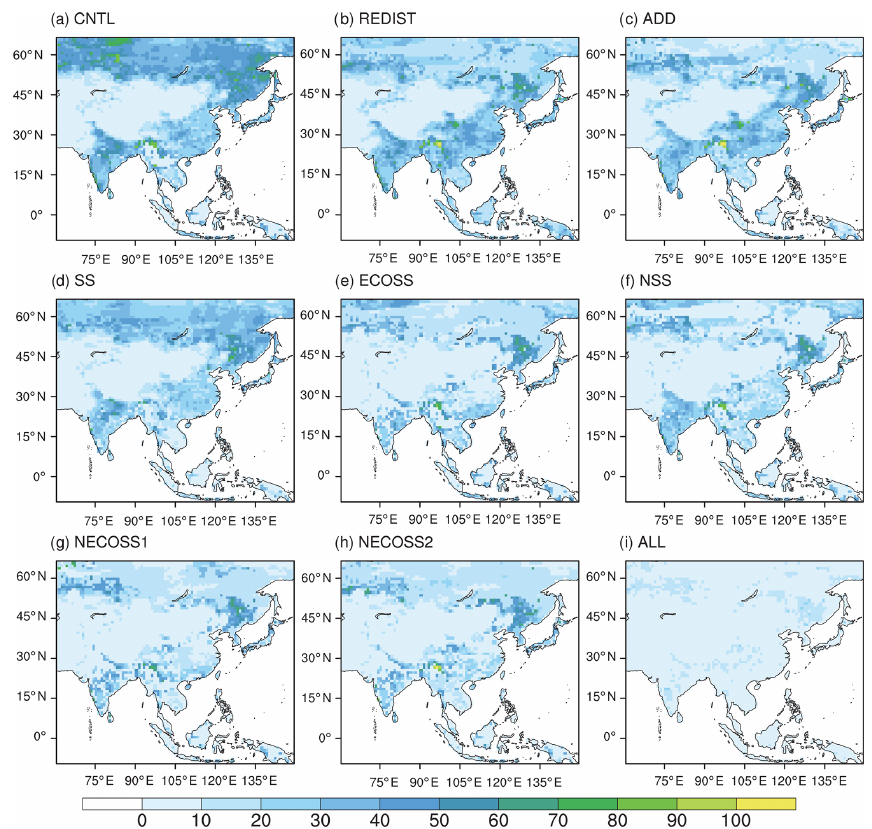
Figure 9. The spatial distribution of the average of weekly RMSD of surface CO 2 fluxes (gCm − 2 yr − 1 ) for (a) the CNTL, (b) the REDIST, (c) the ADD, (d) the SS, (e) the ECOSS, (f) the NSS, (g) the NECOSS1, (h) the NECOSS2, and (i) the ALL experiments. Table 6. The averaged statistics of surface CO 2 fluxes (gCm − 2 yr − 1 ) for the experiments conducted in this